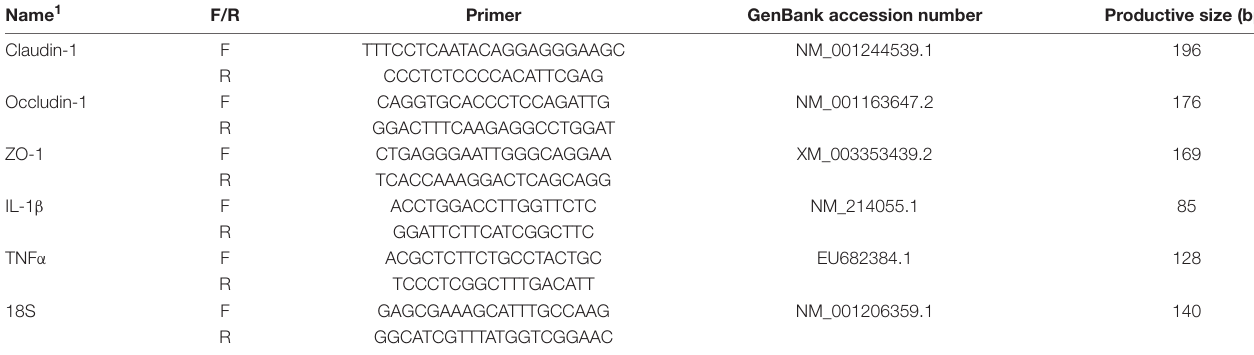
TABLE 2 | RT-PCR primers related to tight junction and inflammation.